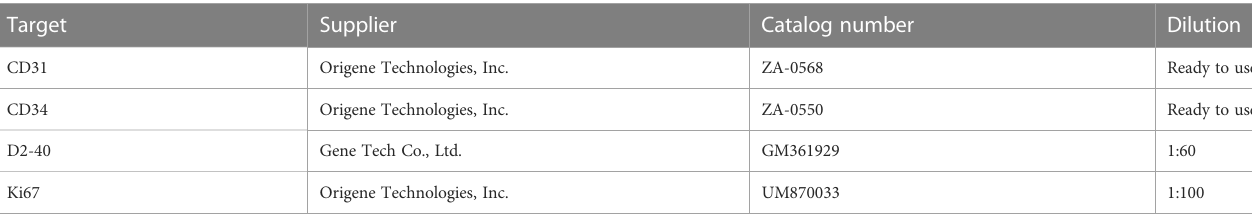
TABLE 1 Primary antibodies used for